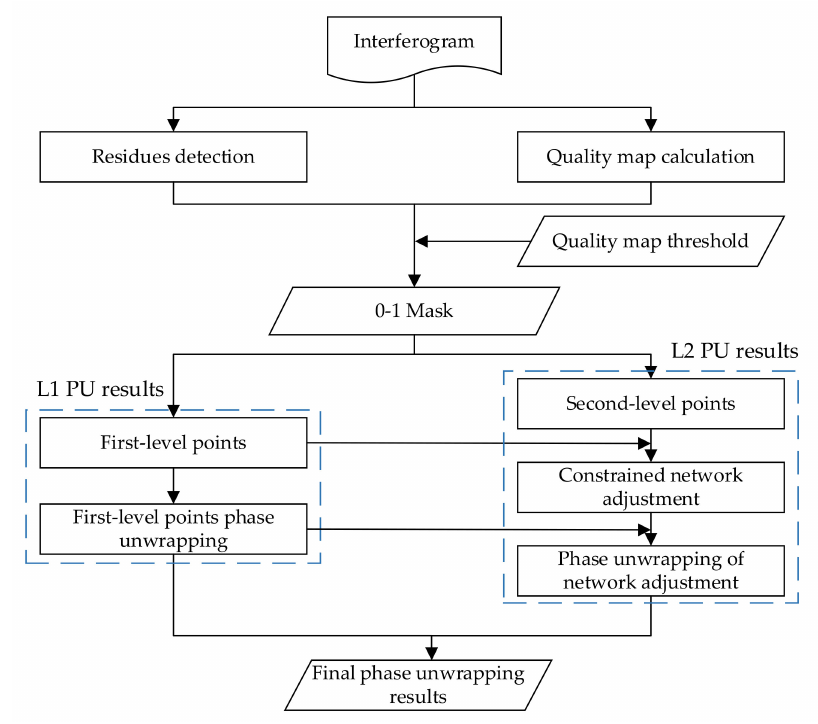
Figure 3. The flow chart of the proposed method